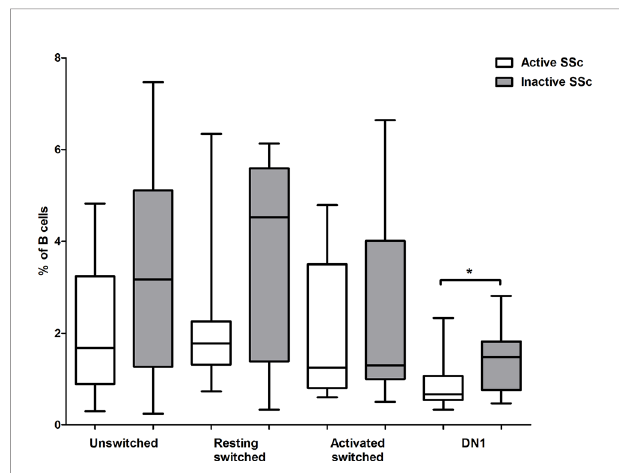
FIGURE 5 | Changes in the proportion ofmemory B cell subsets inactive disease. The percentages ofCD19+IgDloCD27+CD38+ unswitched,CD19+ IgD − CD27 − CD38+ doublenegative (DN) 1, CD19+IgD − CD27+CD38+CD95 − resting switched and CD19+IgD − CD27+CD38 − CD95+ activatedswitched memory B cells were analyzed inactive (n = 10)and inactive (n = 11)SSc patients. The boxes show interquartile ranges (IQR),the horizontal lines represent mediansand thewhiskers indicate the lowest andhighest values.